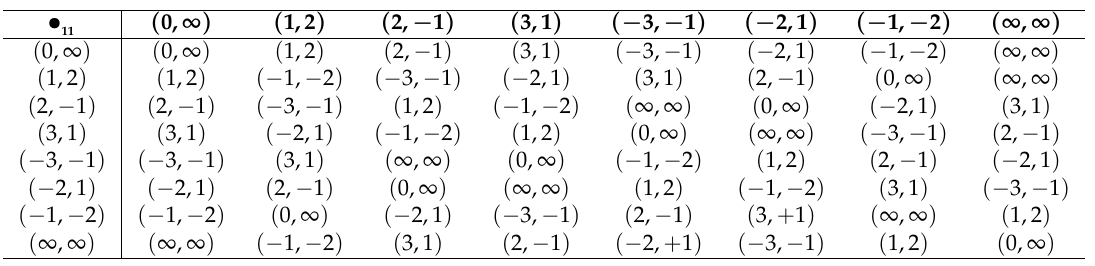
(cid:0) (cid:1) ( f ) , • Q Z . 1,1 a , b 7